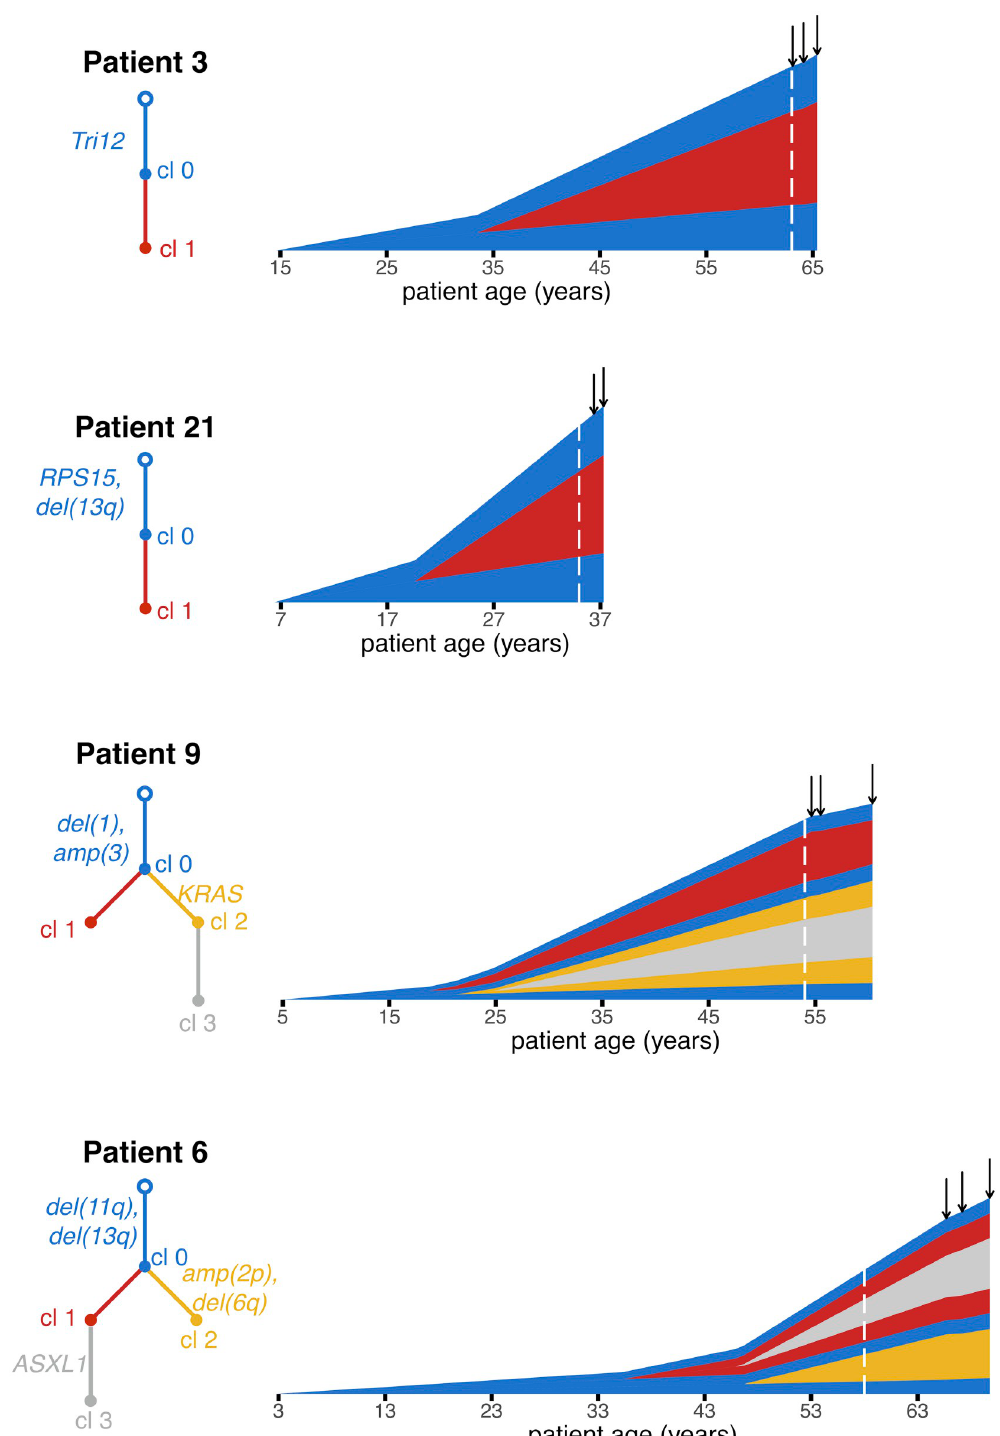
Fig 4. Reconstructing the timeline of CLL evolution in patients. We applied our methodology to estimate subclonal growth rates, mutation rates and evolutionary timelines in CLL tumors from Ref. [27]. Vertical height of a clone represents its log 10 -scaled size. Mutations were clustered into clones and phylogenetic trees were inferred using PhylogicNDT [43]. Tree edges are colored by clone number and are labeled with driver mutations, if any. For each patient, we show estimates for patient age at CLL initiation and times of appearance of CLL subclones. Dashed white line indicates when the patient was diagnosed. Solid black arrows indicate times of bulk sequencing measurements.